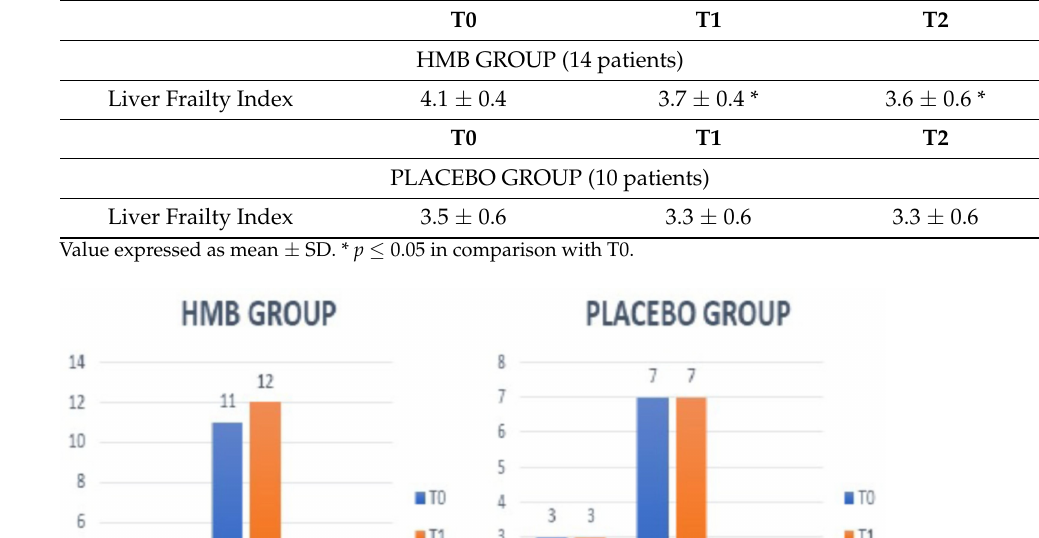
Table 5. Changes in Liver Frailty Index across the study.